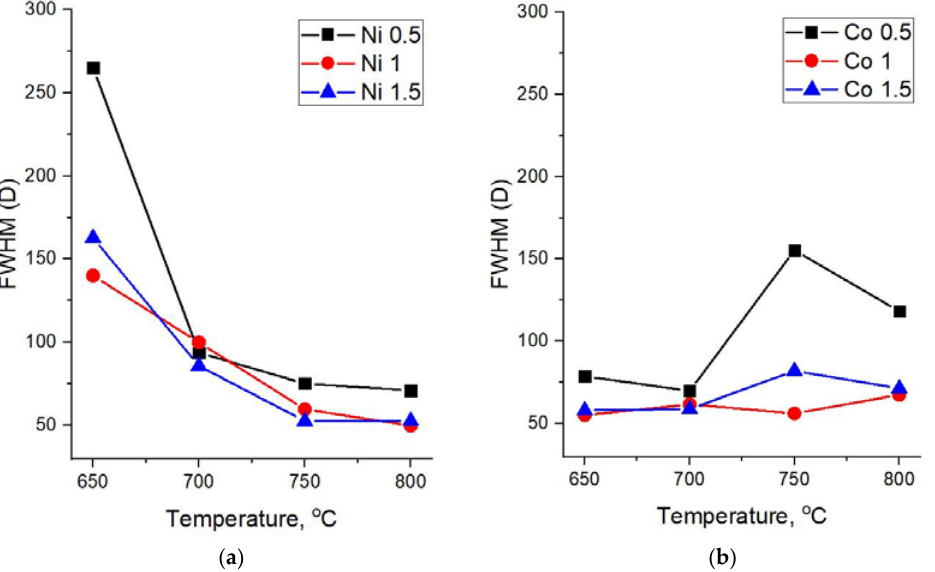
Figure 5. Dependence of the FWHM of the D peak on the synthesis temperature. ( a ) Ni and ( b ) Co catalysts.